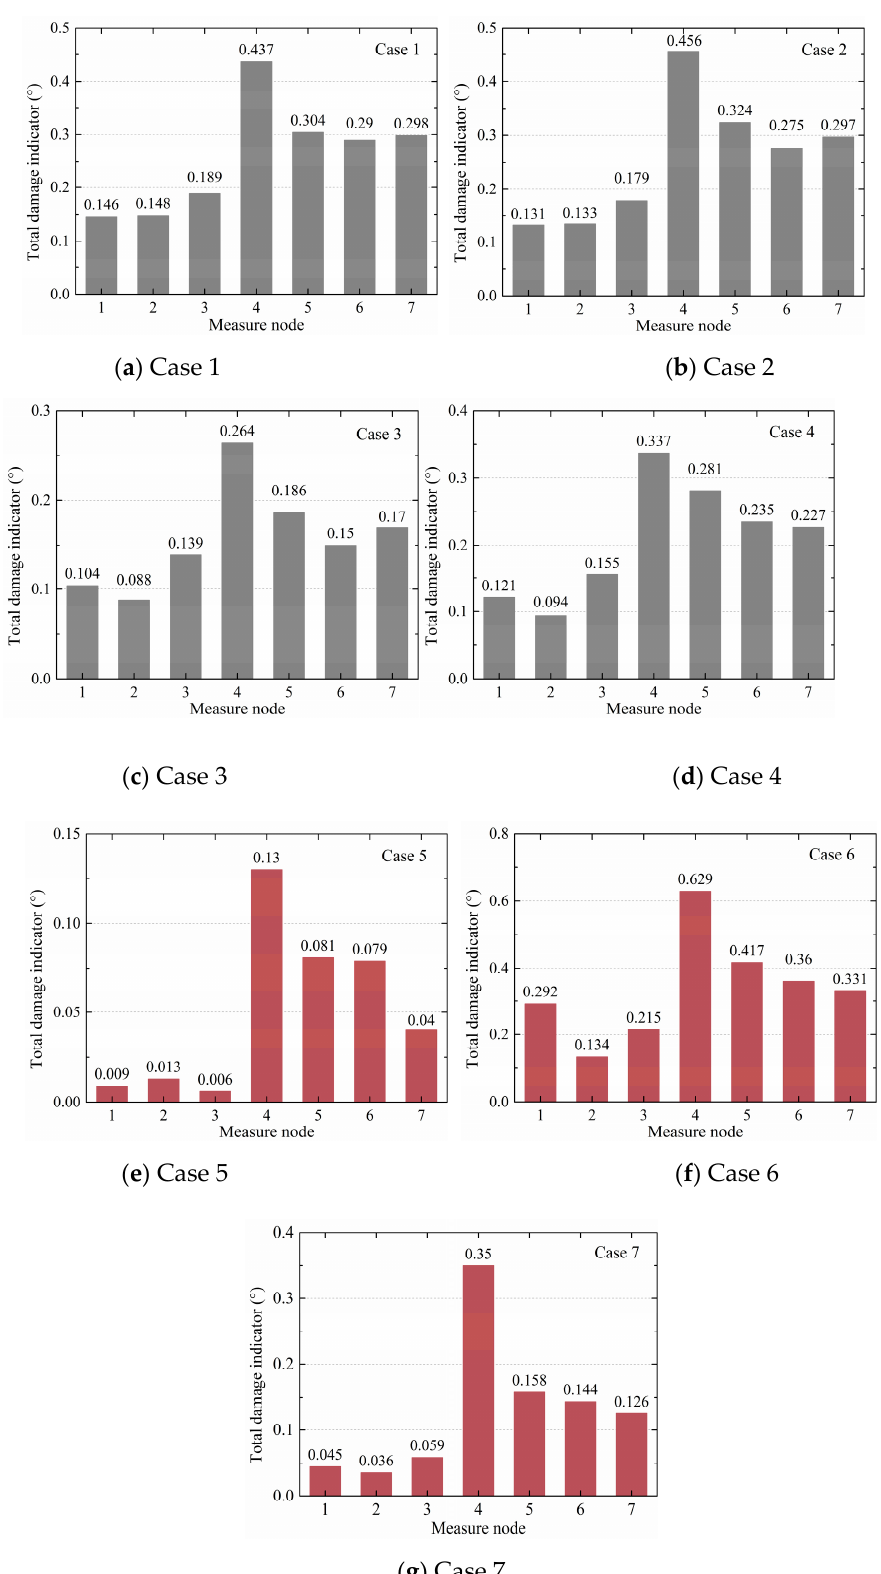
Figure 19. Total damage indicators of cases 1 − 7 as histograms.